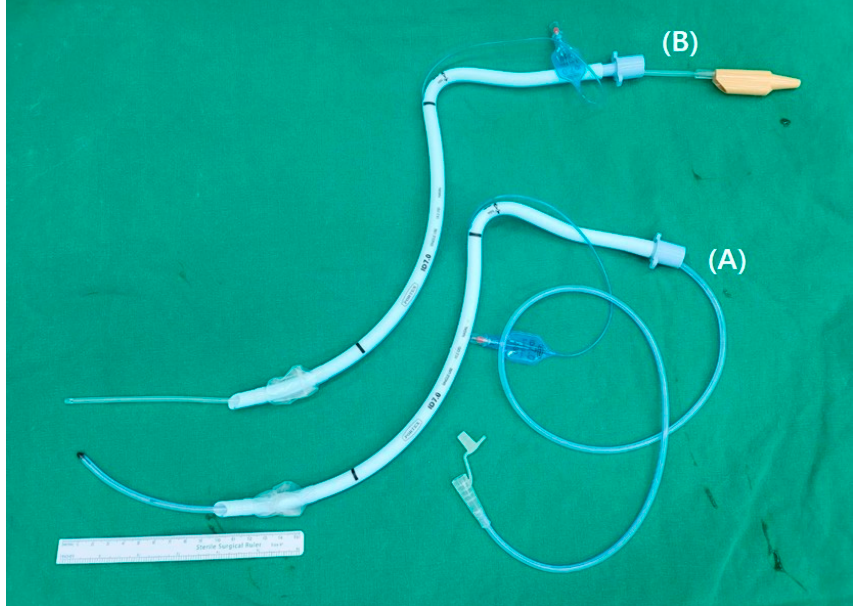
Figure 1. Preformed nasotracheal tubes with guiding devices: ( A ) Nasogastric tube. ( B ) Suction catheter.